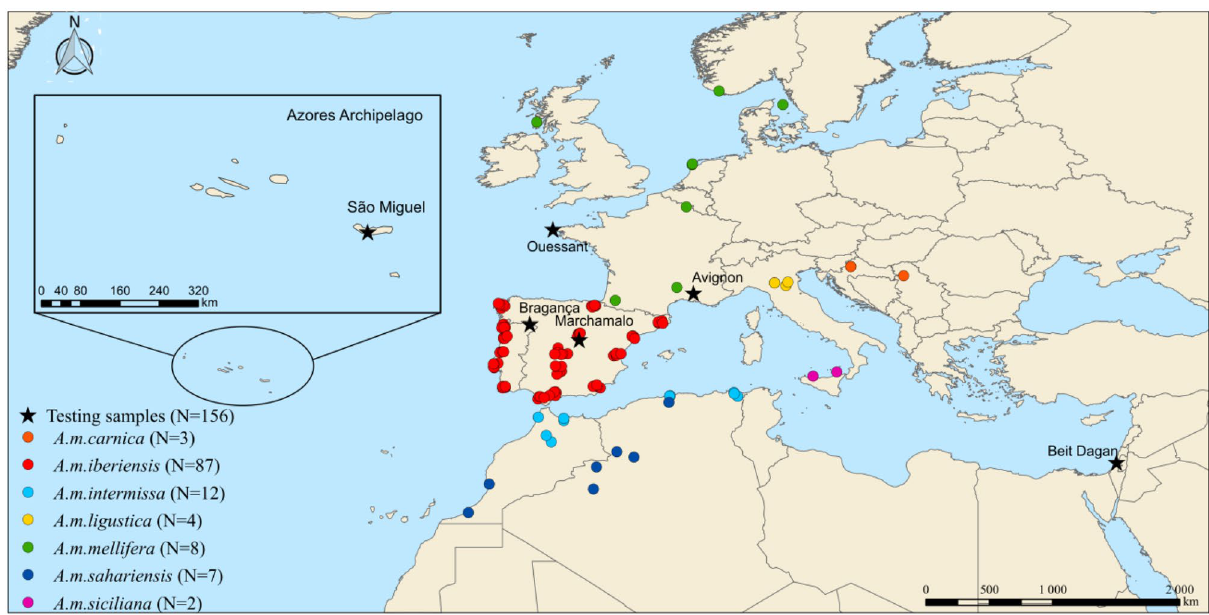
QGIS 3.12.2- Bucure ș ti- https:// qgis. org/ es/ site/ forus ers/ downl oad.